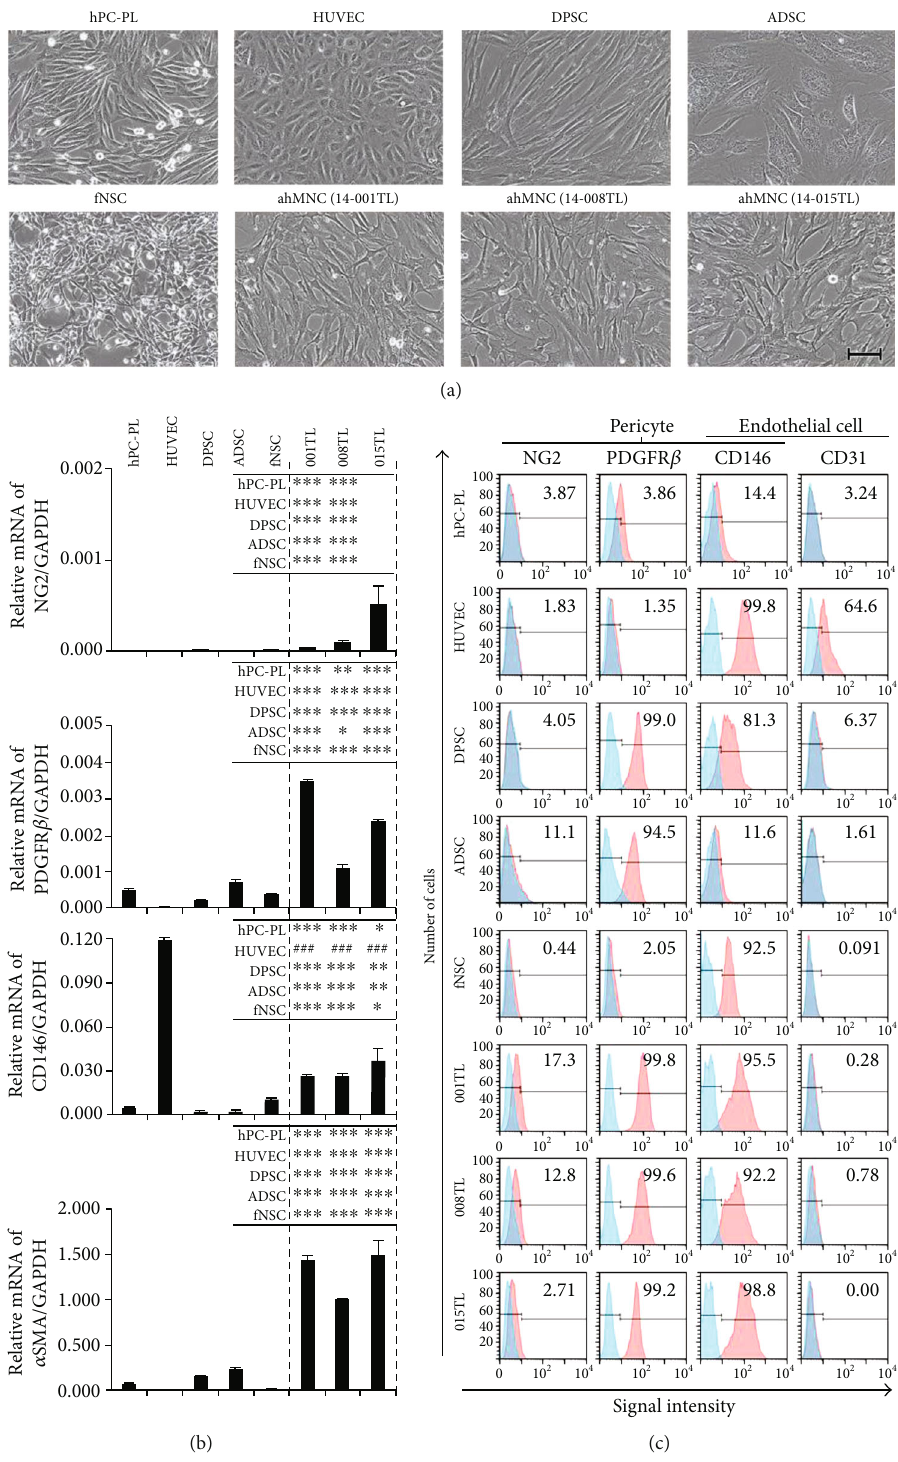
Figure 2: Expression of pericyte markers in ahMNCs. (a) Morphologies of cell types tested were illustrated. Scale bar, 100 μ m. (b) Levels of mRNAs of pericyte markers were analyzed by RT-qPCR. Height = average , error bar = SD . Inlet tables indicate statistical signi fi cance between ahMNCs and other cell types. ∗ and # represent signi fi cantly higher and lower levels in ahMNCs, respectively. ∗ P < 0 : 05 , ∗∗ P < 0 : 03 , ∗∗∗ P < 0 : 01 , and ### P < 0 : 01 . (c) Protein levels of NSC (NG2), pericyte (NG2, PDGFR β , and CD146) or endothelial cell (CD146 and CD31) markers were analyzed by fl ow cytometry. Number in each panel indicated percent of marker-positive